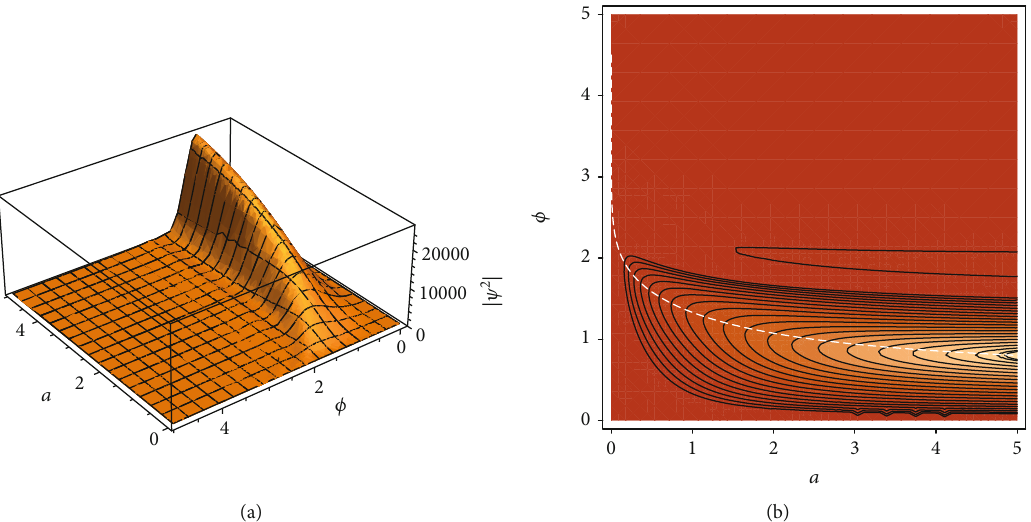
Figure 6: The fi gures show the square of the wave function (a) and its corresponding contour plot (b) for the early times of cosmic evolution. Also, the dashed line denotes the classical trajectory of the system in the plane a − ϕ . The fi gures are plotted for the numerical values: g = 2 , λ = 1 , m = 2 , p = 0 , σ = 1 , and w g s